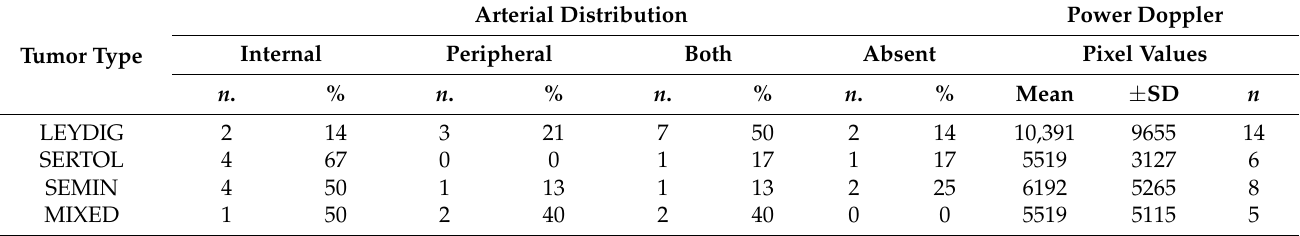
Table 4. Power Doppler characterization of arterial distribution in different tumor lesions ( n = 33) included in the comparative analysis and color signals in pixels (mean values ± SD). The arteries (number and relative frequency) were categorized as intralesional, perilesional, intra/perilesional, or absent.